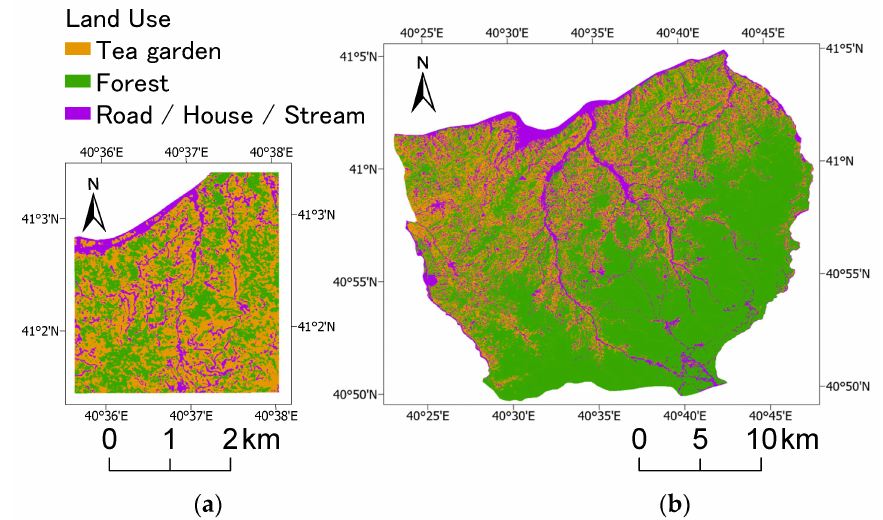
Figure 6. Land use map ( a ) in 2010 and ( b ) 2021. Table 3. Confusion matrix between ground truth and classified land use in 2010.